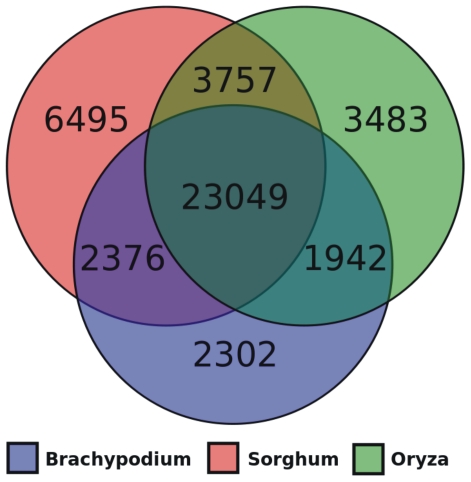
Venn diagram showing wheat read distribution with a significant similarity to Brachypodium, rice and sorghum.